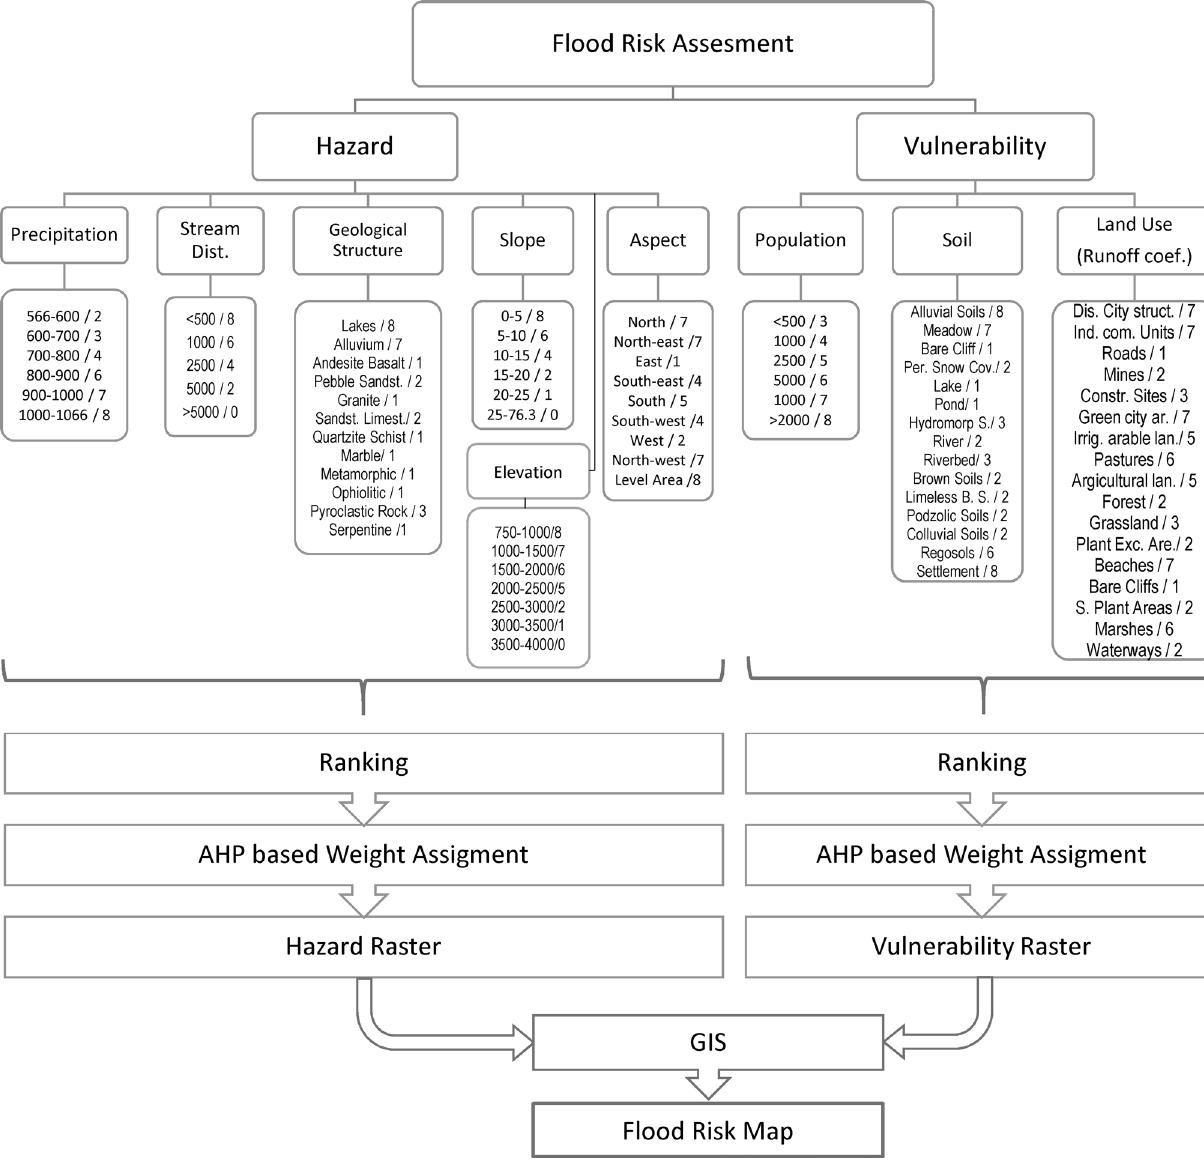
Table 4. Another parameter effective on the flood is the run- off coefficient. Since the amount of runoff from precipitation